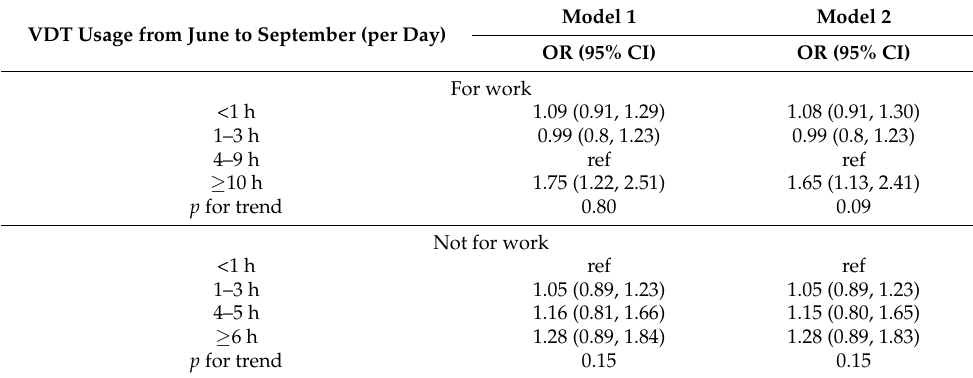
Table 2. Association between the VDT usage and poor self-rated health.